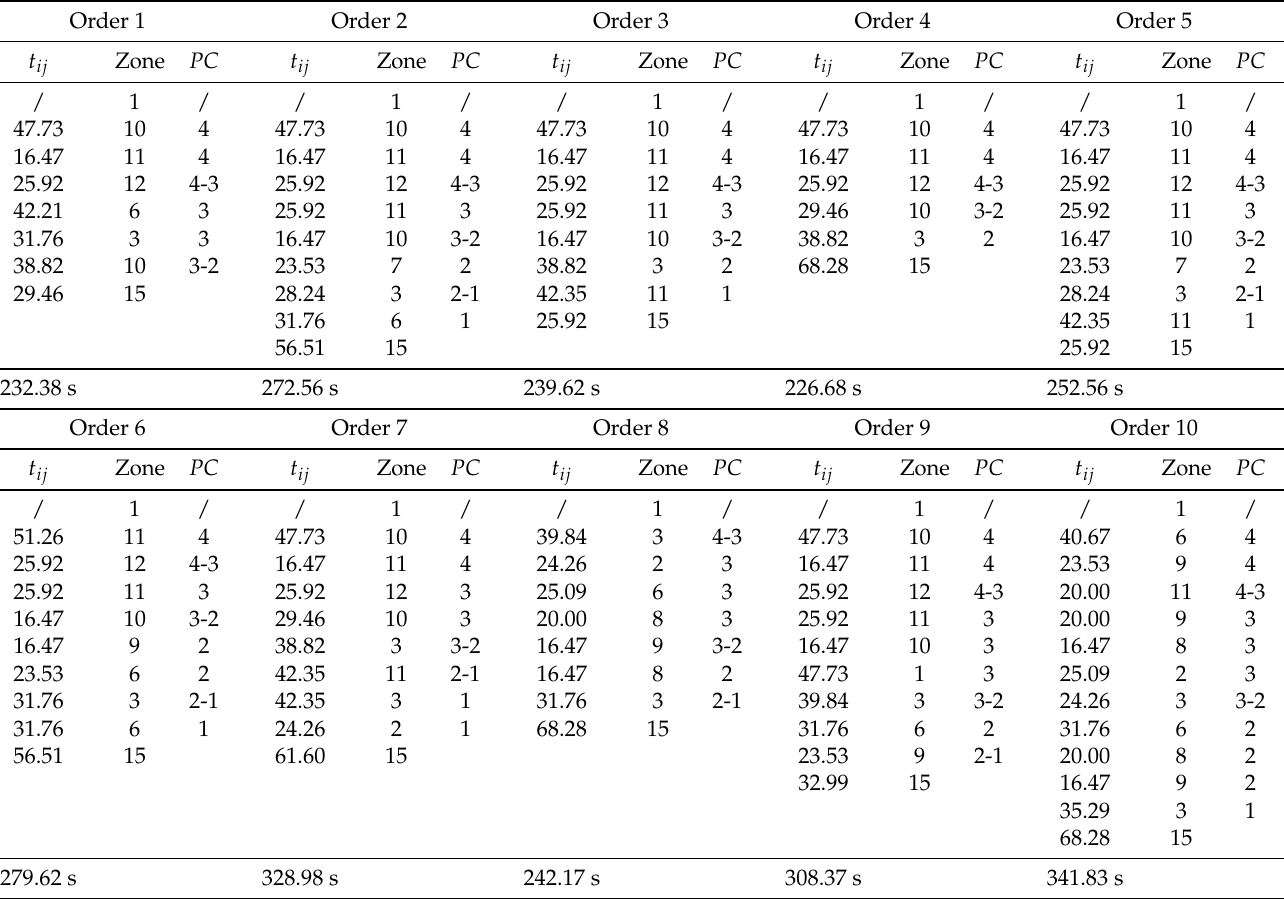
Table 5. Simulation of travel times for 10 BOPS orders when the Relaxed SOP optimization is